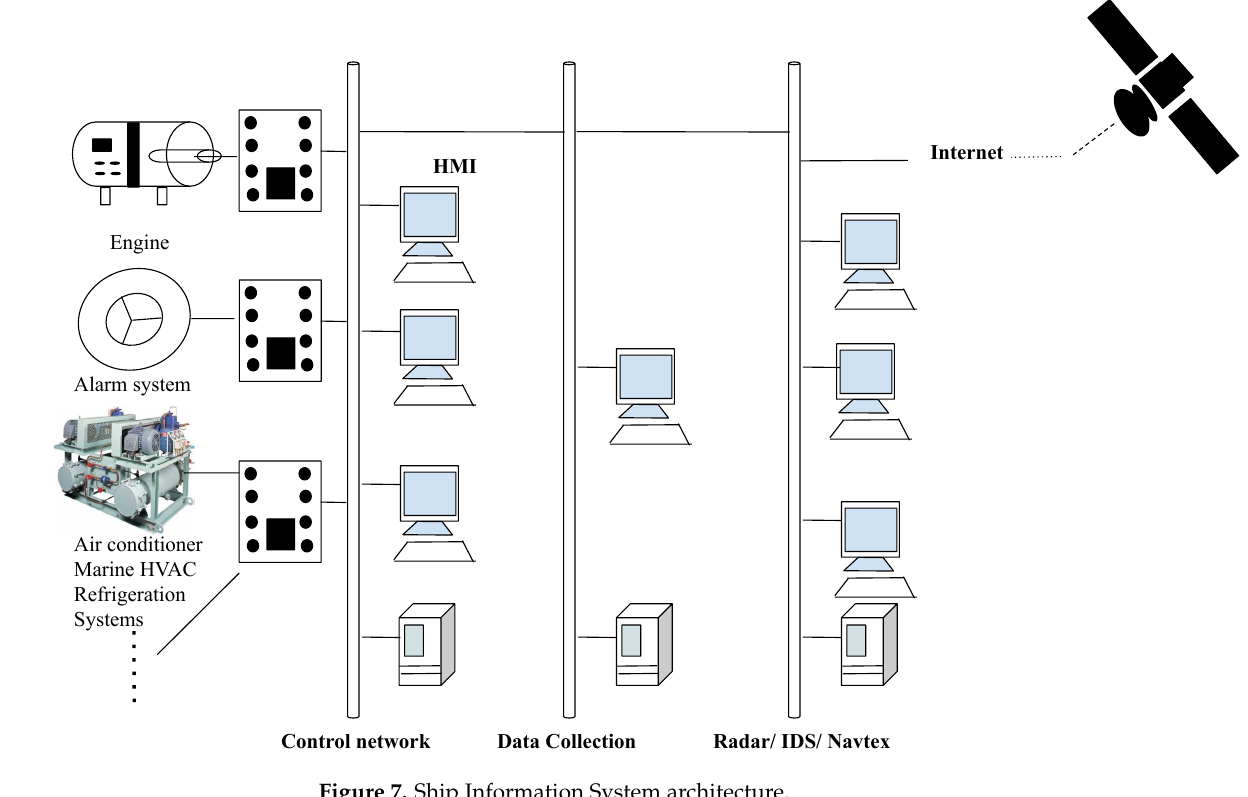
Figure 7. Ship Information System architecture.